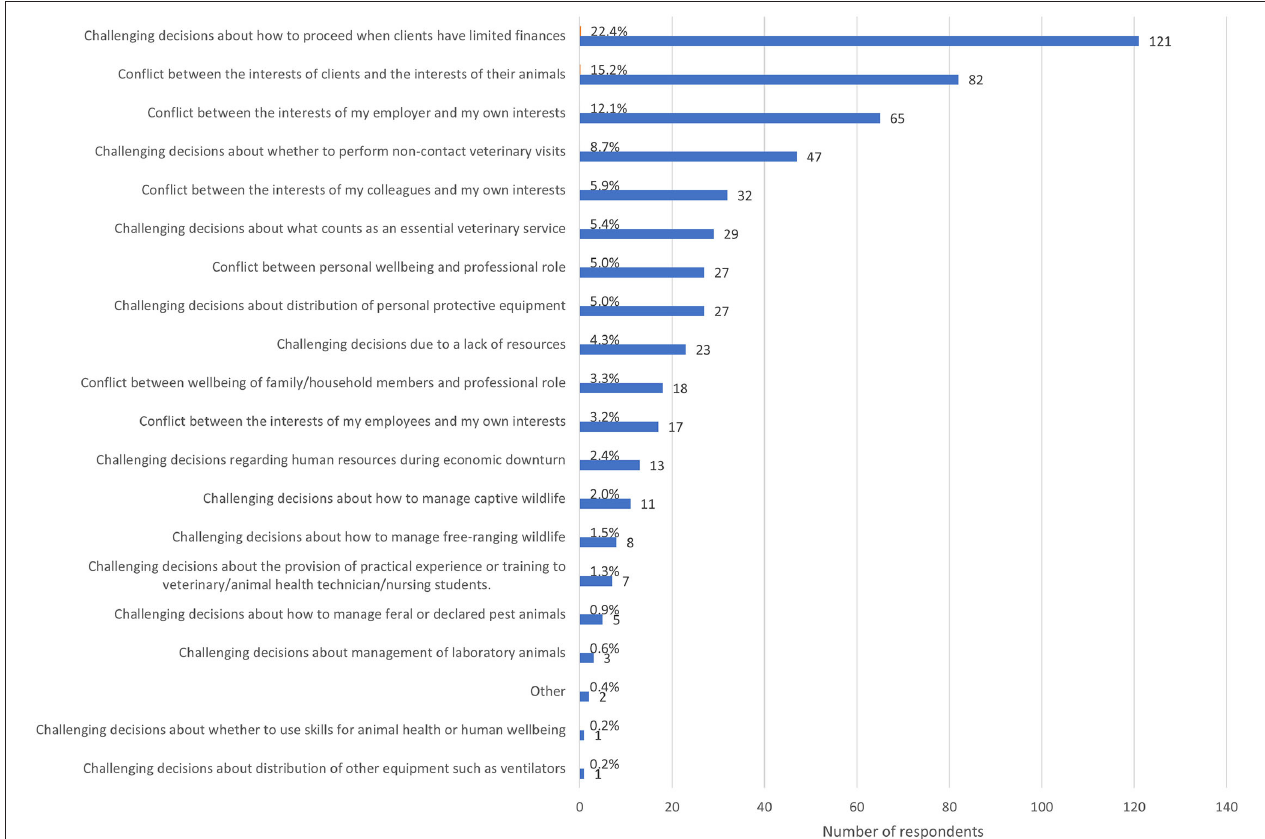
FIGURE 4 | Bar chart of the frequency of the of the most recent type of ethically challenging situation encountered by veterinary team members since the advent of the COVID-19 pandemic, based on the responses of539 veterinarians, animal health technicians and veterinary nurses, surveyed between May and July in